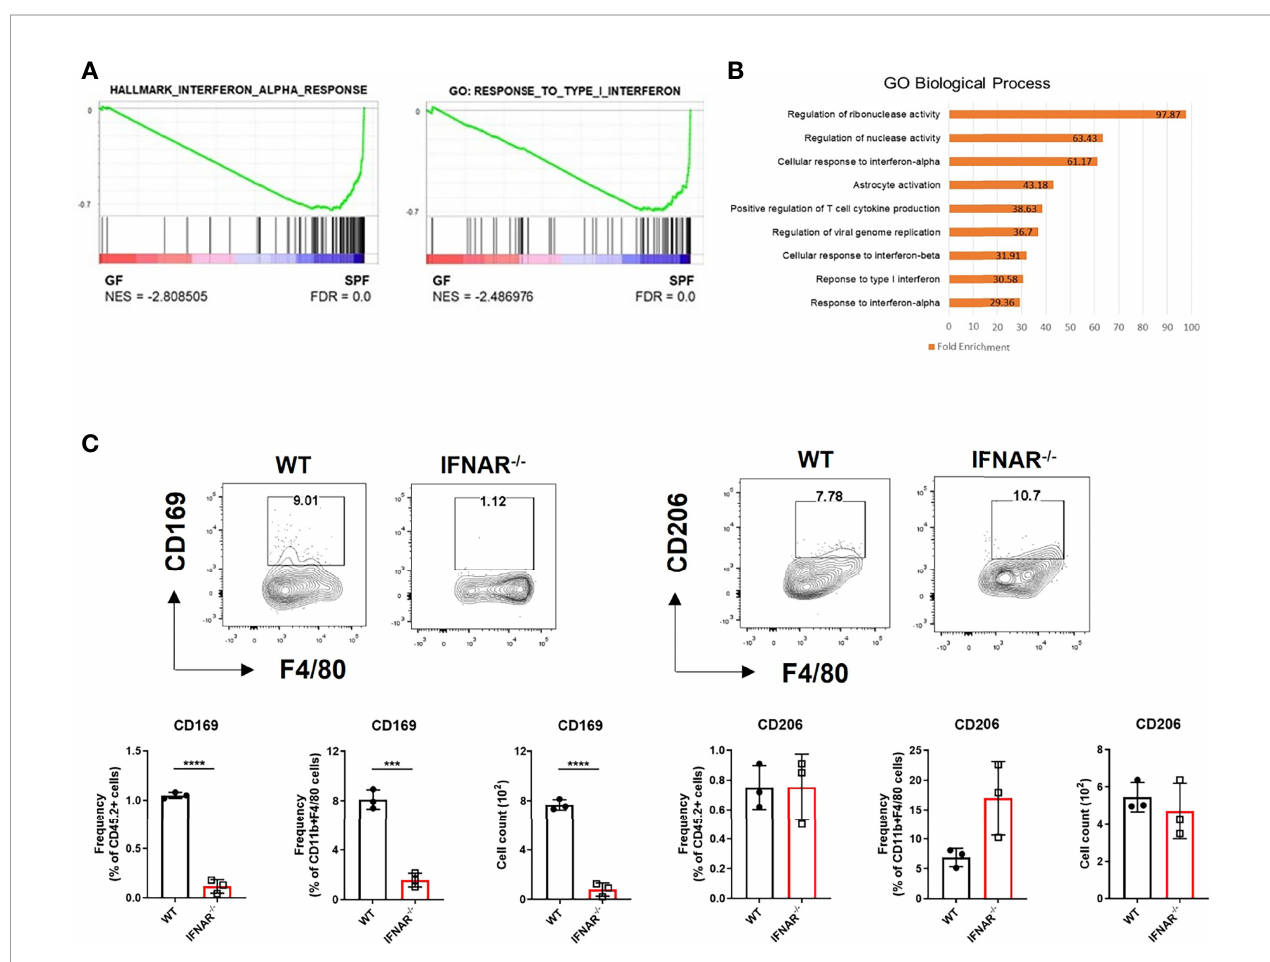
FIGURE 1 | Diminished type I IFN signaling in germ-free skin alters expression of macrophage-speci fi c marker, CD169. (A) Gene set enrichment analysis (GSEA) enrichment plots performed on two gene set collections (h.all.v7.2.symbols.gmt and c5.all.v7.2.symbols.gmt) in germ-free (GF) and speci fi c pathogen-free (SPF) mice from data published in Meisel et al., 2018 (GSE98877 from GEO database). GSEA performed 1000 permutations. (B) Gene Ontology analysis of GSE98877. (C) Representative FACS plot and graphs showing frequency and cell counts of CD169 + and CD206 + myeloid cells in skin of WT and Ifnar KO mice (n = 3 per group). The cells were gated on FSC/SSC, PI - , singlet, CD45.2 + , CD11b + , F4/80 + cells. Data represent two independent experiments. Data are expressed as means ± SEM. Horizontal lines above bars indicate statistical comparisons with statistical differences between categories (***p < 0.001, ****p <